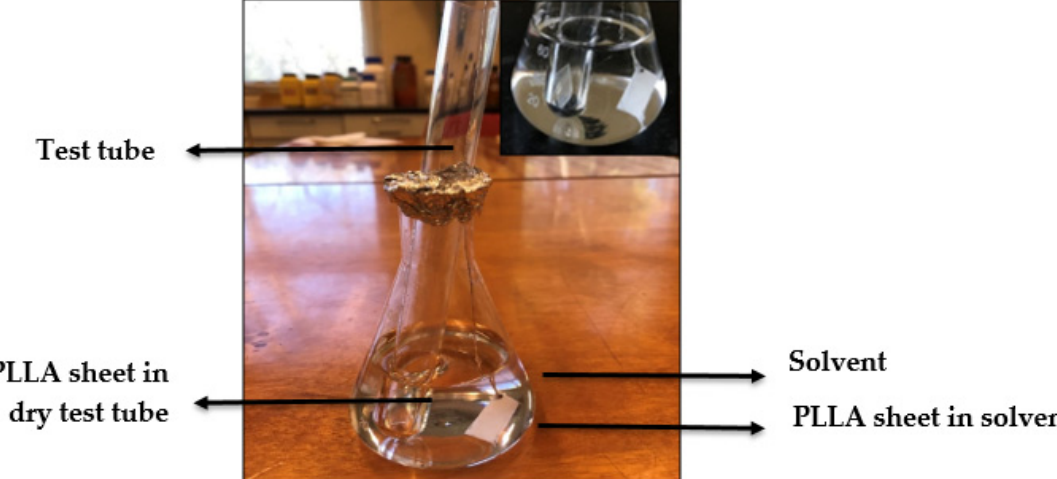
Figure 1. Experimental set-up for thermal annealing and solvent-induced crystallization of poly- L - lactide